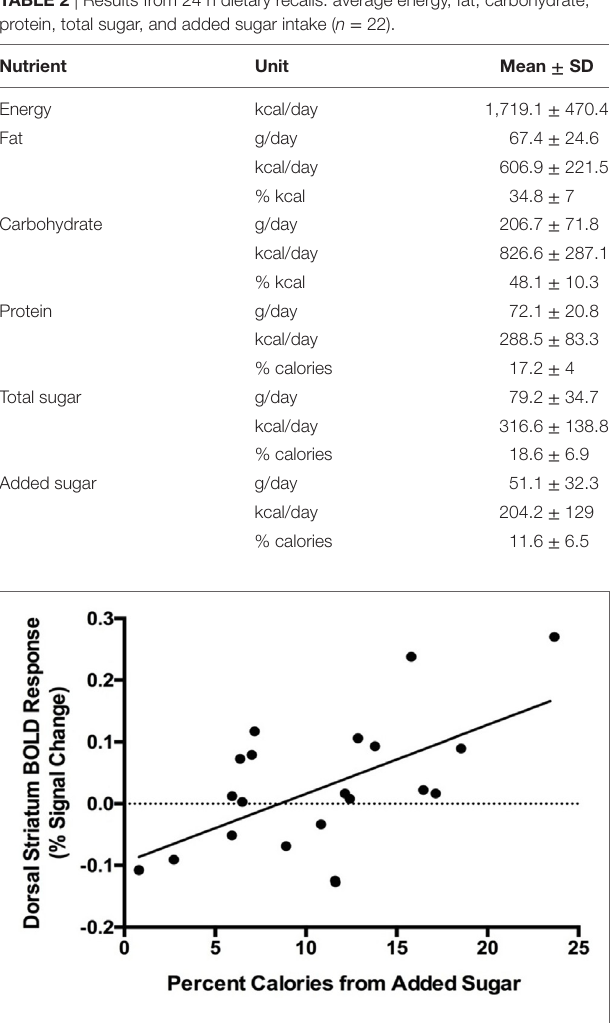
FigUre 2 | Positive correlation between blood oxygen level-dependent (BOLD) response to food cues in the dorsal striatum and percent calories consumed from added sugar ( r s = 0.55, p = 0.02). One male participant was excluded from analysis due to an imaging acquisition error.